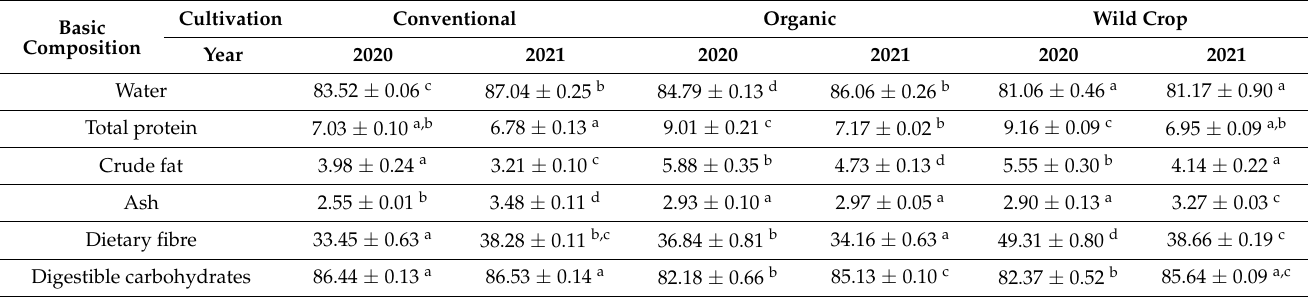
Table 1. Basic composition in fruits of raspberries from conventional and organic practices as well as those wild grown (g 100 g − 1 dry